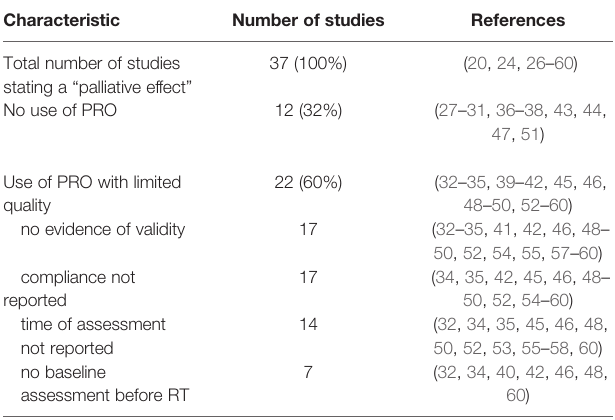
TABLE 1 | Use of patient-reported outcomes and reasons for limited quality of their assessment in studies reporting a “ palliative effect ” .